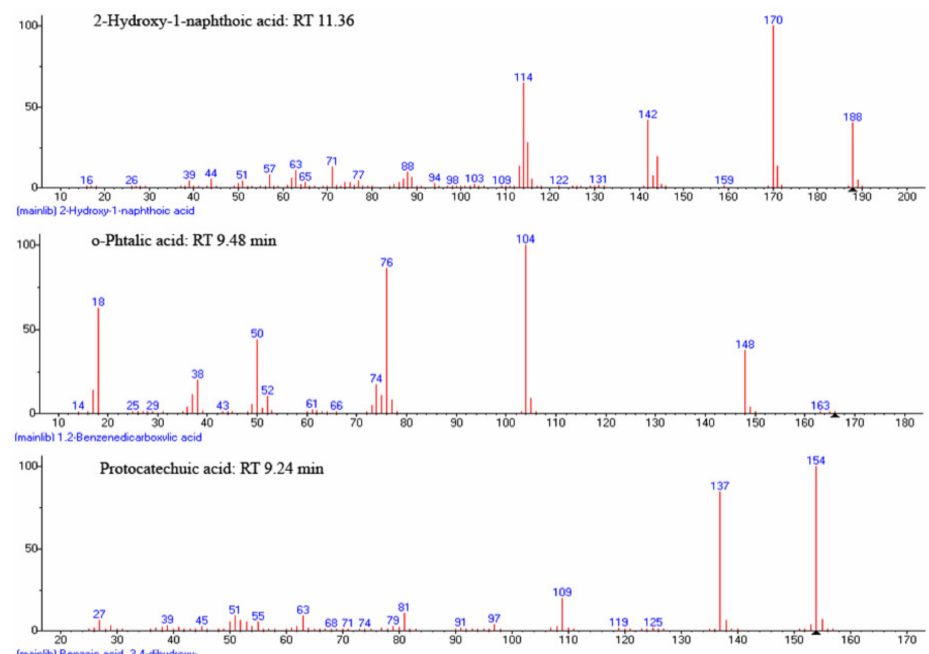
Figure 6. Mass spectral profiles of anthracene intermediate